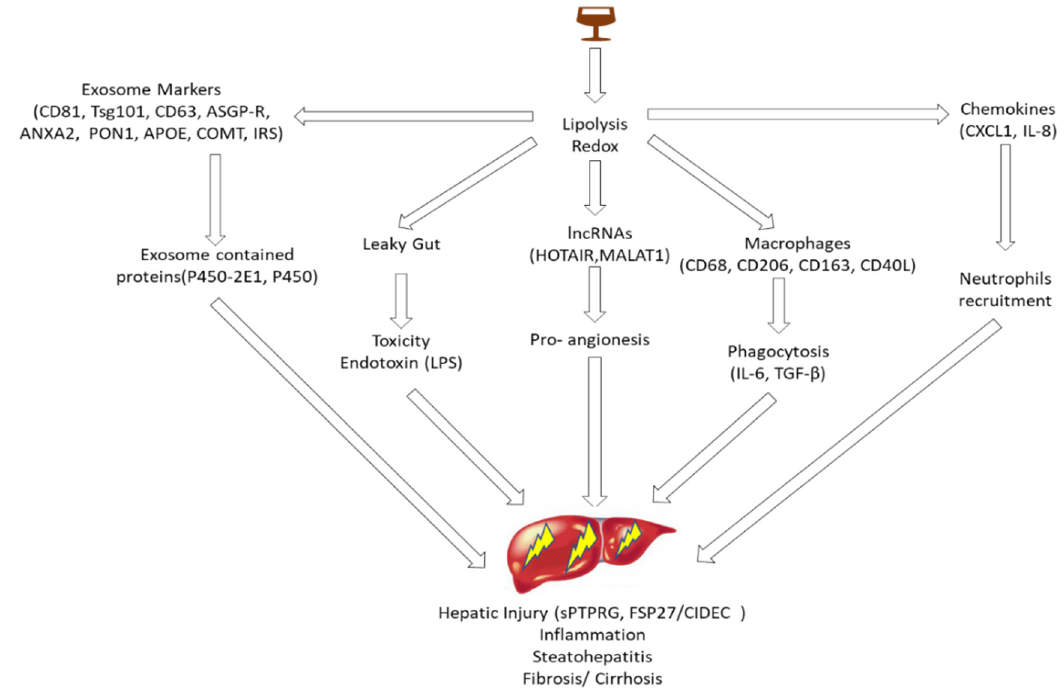
Figure 3. The summary of the liquid factors associated with liver inflammation in Alcoholic liver disease disease (ALD).